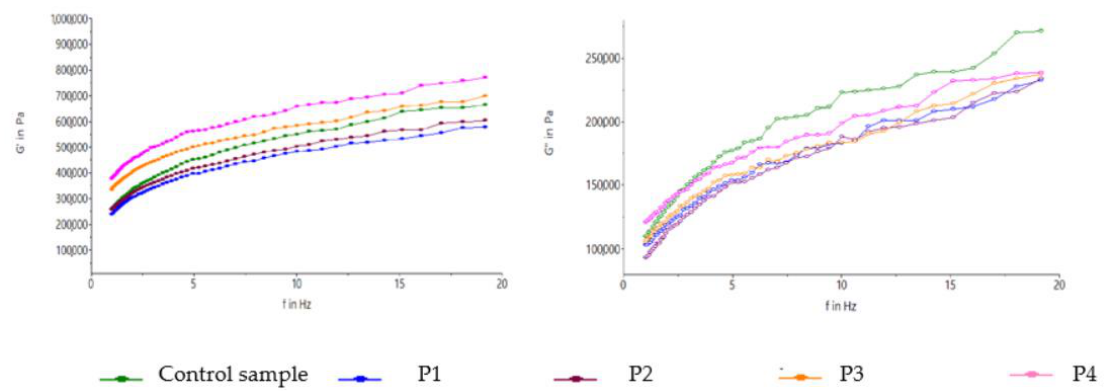
Figure 1. Effect on rheological properties on the frequency sweep test.